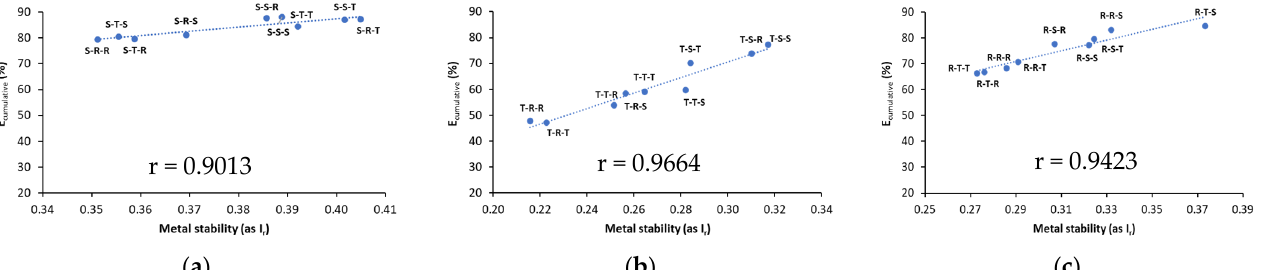
Figure 6. A relationship between cumulative Cu removal efficiency (E cumulative ) and stability of residual Cu in washed soil (I r ) for different biosurfactant variants: ( a ) saponin variant, ( b ) tannic acid variant, ( c ) rhamnolipids variant.